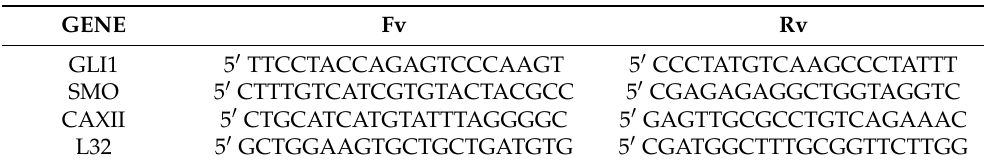
Table 2. RT-qPCR